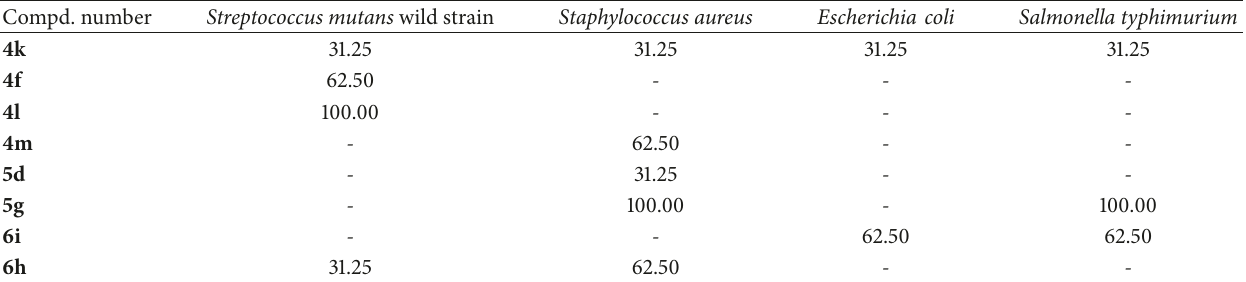
Table 2: Minimum inhibitory concentration (MIC, 𝜇 g/mL) of bioactive synthetic compounds against target pathogenic bacteria. Compd.